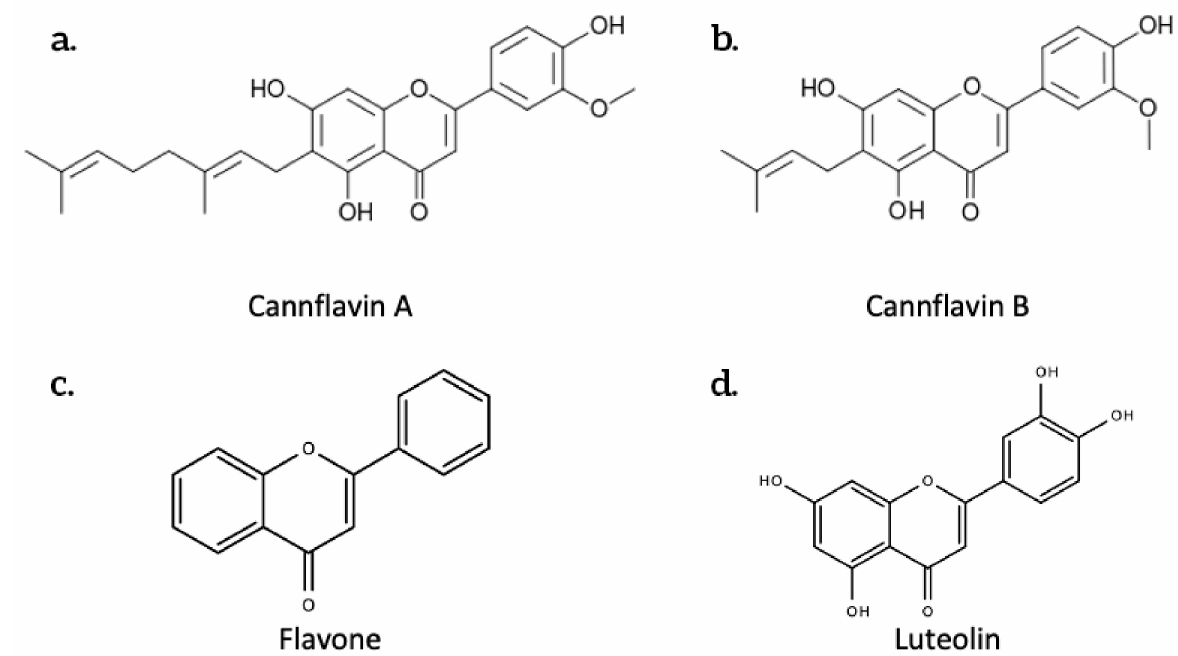
Figure 3. The chemical structures of some flavonoids produced by Cannabis sativa L. ( a .) Cannflavin A; ( b .) Cannflavin B; ( c .) Flavone; ( d .)